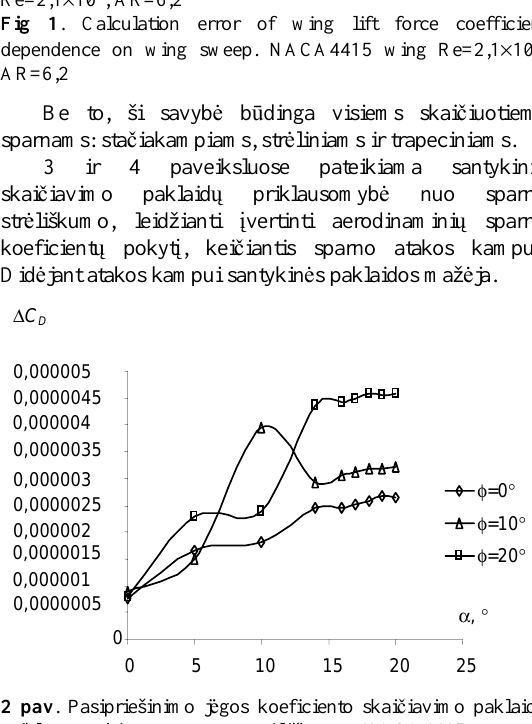
Fig 2 . Calculation error of wing drag force coefficient dependence on wing sweep. NACA4415 wing Re=2,1 × 10 6